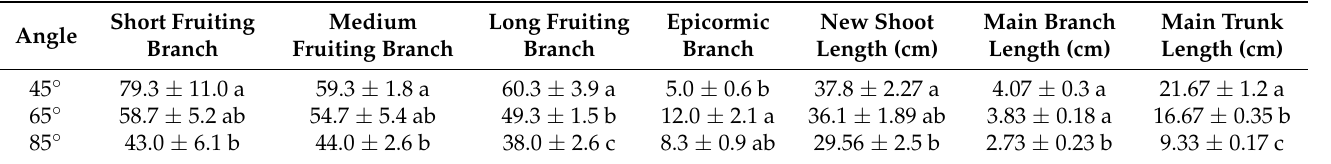
Table 2. Effects of different opening angles on the composition of branches.